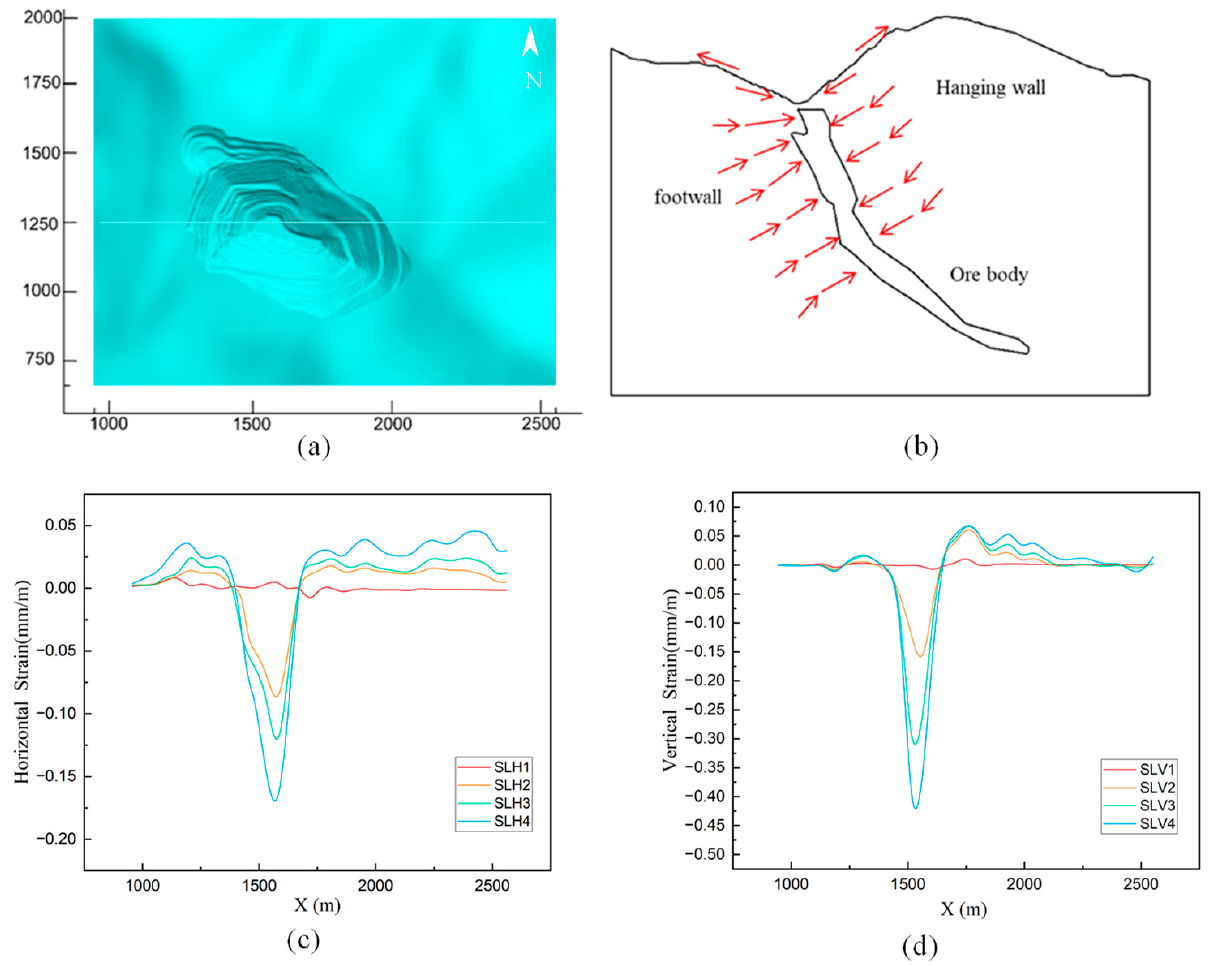
Figure 17. Deformations along y=1250 on the surface ( a ) Position of the line where we take the deformation; ( b ) Pattern of rock mass movement; ( c ) Horizontal strain along the line; ( d ) Vertical strain along the line.